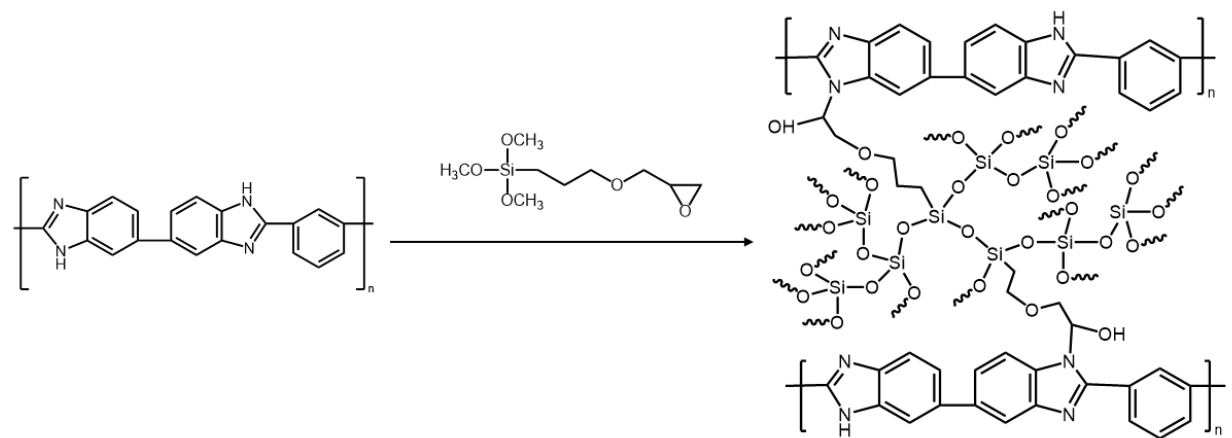
Figure 1. Chemical crosslinking of PBI with GPTMS.